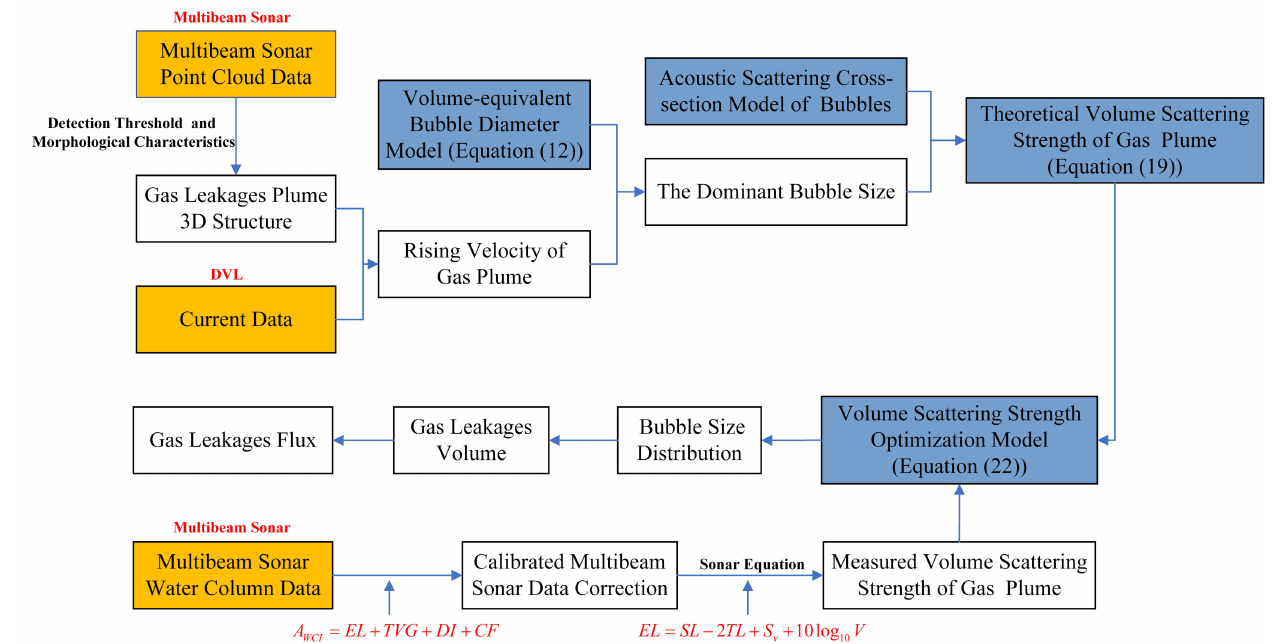
Figure 9. The gas leakage acoustic quantitation flowchart, where orange blocks represent the input data obtained from the multibeam sonar and doppler velocity log (DVL), and blue blocks denote the applied